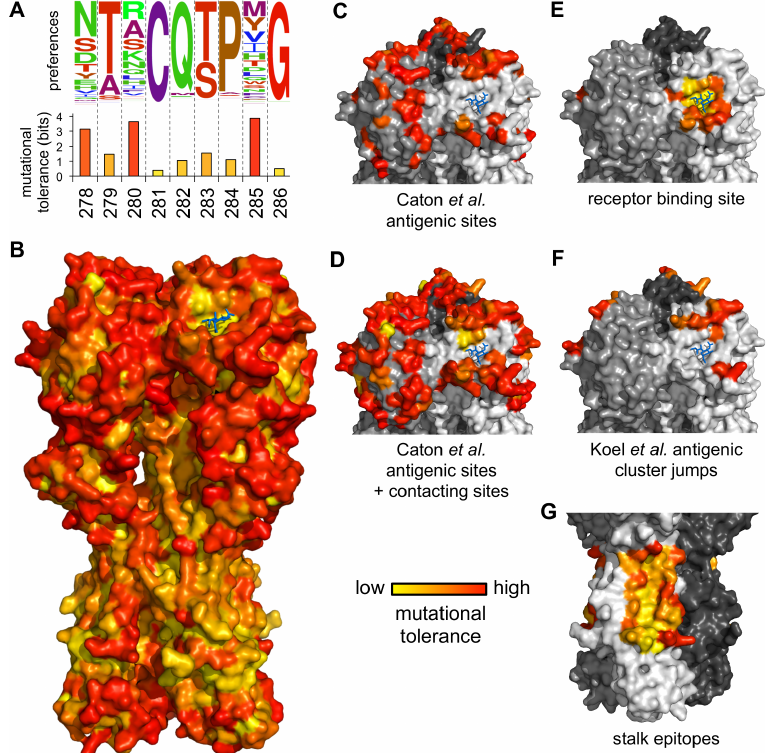
Figure 5. Antigenic sites in HA’s globular head have a high inherent tolerance for mutations, but HA’s stalk is relatively intolerant of mutations. ( A ) Mutational tolerance is calculated as the Shannon entropy of a site’s amino-acid preferences. ( B ) Mutational tolerance mapped onto the HA trimer ( yellow indicates low tolerance, red indicates high tolerance, blue sticks show the sialic-acid receptor). ( C , D ) The antigenic sites defined by Caton et al. [33] have high mutational tolerance, as do the residues contacting these sites. ( E ) Conserved receptor-binding residues have low mutational tolerance. ( F ) Sites that contribute to antigenic cluster jumps [34]. ( G ) Sites in the footprints of four broadly neutralizing antibodies have low mutational tolerance. Shown are footprints of F10, CR6261, FI6v3, and CR9114 [35–38]. For panels B-G, tolerance is mapped onto PDB structure 1RVX [39]. For panels C-G, each monomer is shown in a different shade of gray. Figure S6 reports statistical analyses of whether subsets of sites have higher or lower tolerance than expected given their solvent